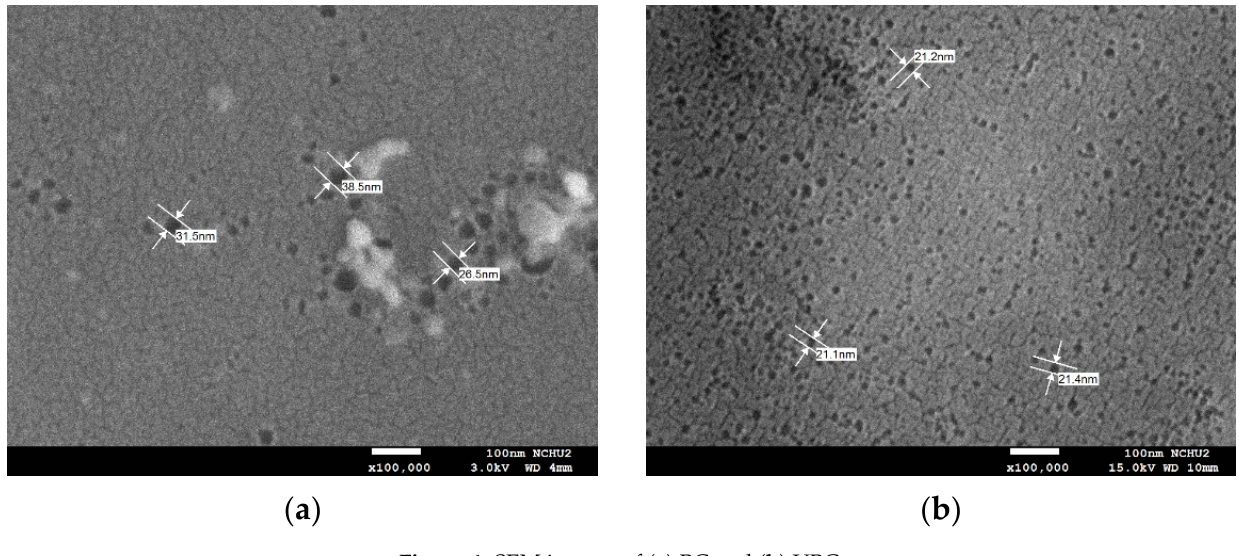
Figure 4. SEM images of ( a ) BC and ( b ) UBC.